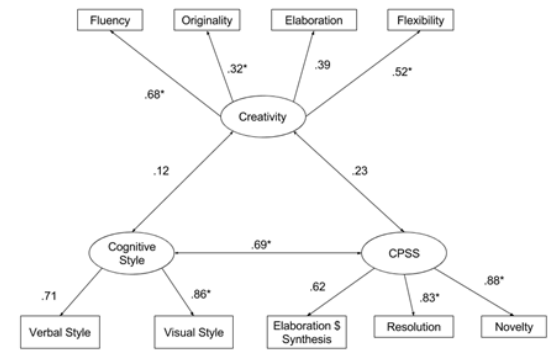
Figure 1. Standardized coefficients for model of creativity, cognitive style, and CPSS. * p <